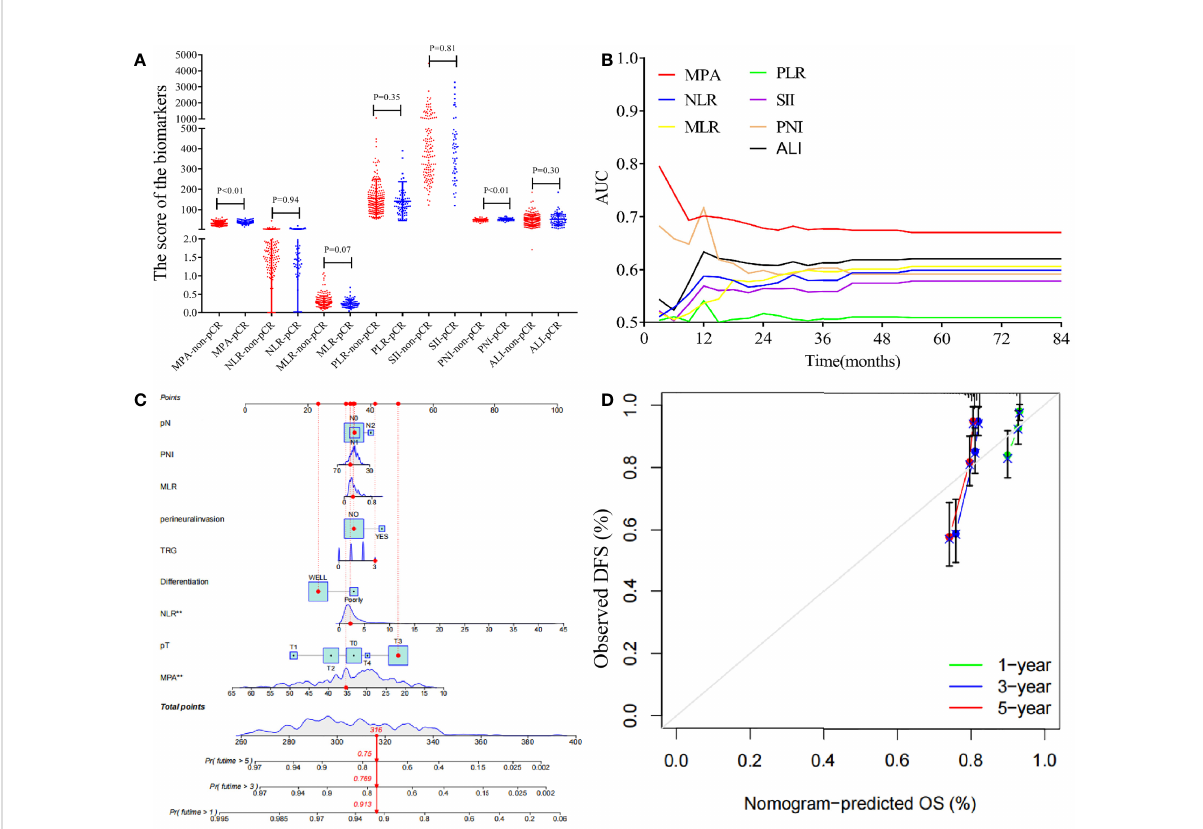
FIGURE 6 Analysis the biomarkers in the patients with LARC and construction a nomogram model for the disease-free survival. (A) The biomarkers value in the pCR group and non-pCR group (MPA: pCR, 37.98 ± 9.02, vs. non-pCR, 31.86 ± 8.62, P < 0.01; NLR: pCR, 2.89 ± 2.94, vs. non-pCR, 2.88 ± 3.45, P = 0.94; SII: pCR, 783.12 ± 1,090.10, vs. non-pCR, 748.26 ± 1,150.48, P = 0.81; PLR: pCR, 141.4 ± 98.22, vs. non-pCR, 154.22 ± 95.11, P = 0.35; MLR: pCR, 0.25 ± 0.12, vs. non-pCR, 0.29 ± 0.17, P = 0.07; PNI: pCR, 51.31 ± 5.33, vs. non-pCR, 49.05 ± 4.84, P < 0.01; ALI: pCR, 52.46 ± 30.4, vs. non-pCR, 47.59 ± 26.36, P = 0.30). (B) Time-dependent AUC curves of the NLR, SII, PLR, MLR, PNI, ALI, and MPA, for the prediction of disease-free survival. (C) Nomogram developed for prediction of disease-free survival. (D) Calibration curves for 1-, 3-, and 5-year DFS for the nomogram in patients with LARC after